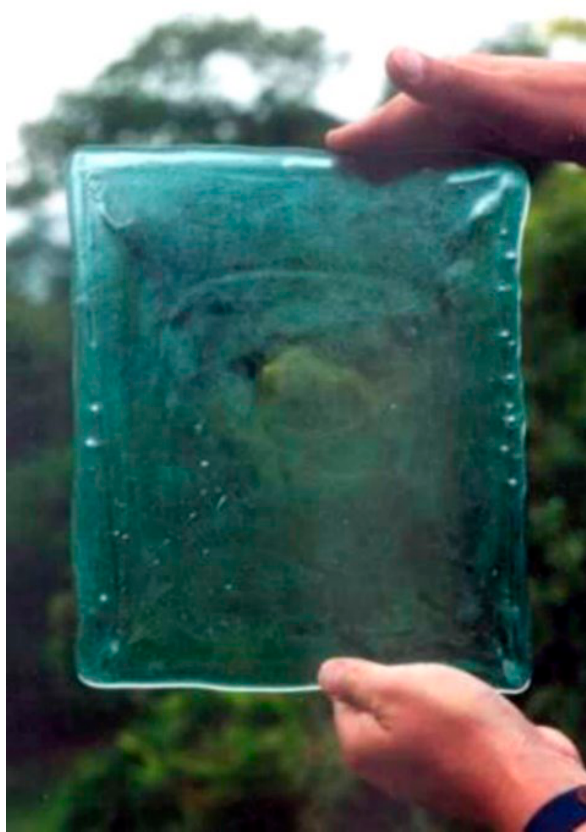
Figure 9. Modern reproduction of Roman window glass (~5 mm thick) [Copyright Mark Taylor and David Hill, used with permis- sion].